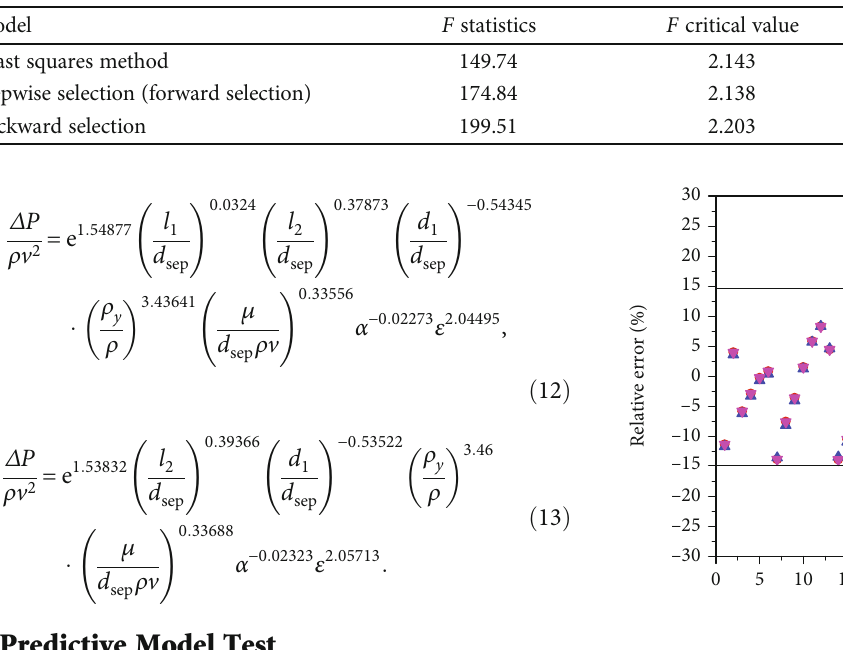
Table 5: Resistance model veri fi cation.